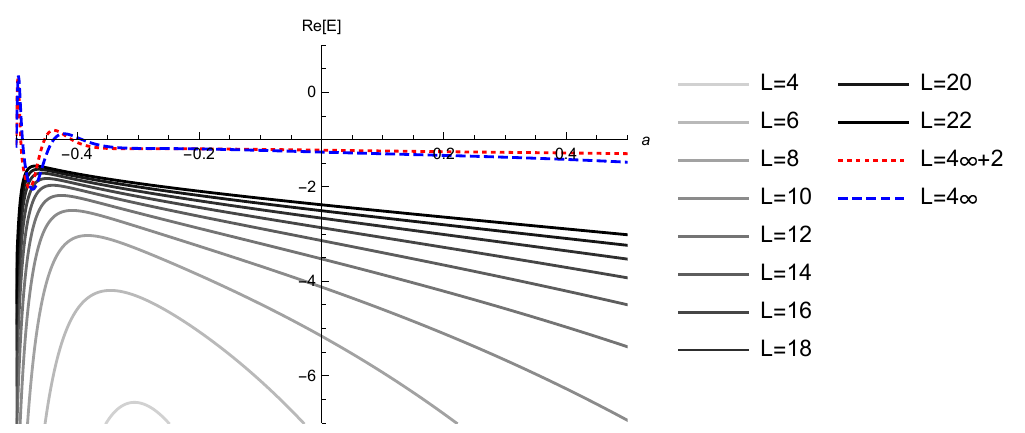
Figure 10 . Plots of the real part of the energy E (2.15) for the “ghost brane” solution Φ G the truncation level L . The dotted and dashed lines are extrapolations to L = 4 k + 2 ( k → ∞ ) and L = 4 k ( k → ∞ ), respectively. The horizontal axis denotes the value of the parameter a at Re E = − 1 .